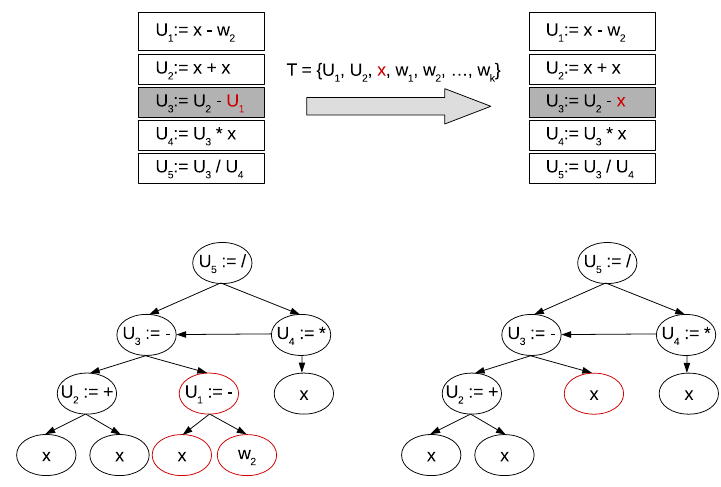
Figure 2. Example of a SLP